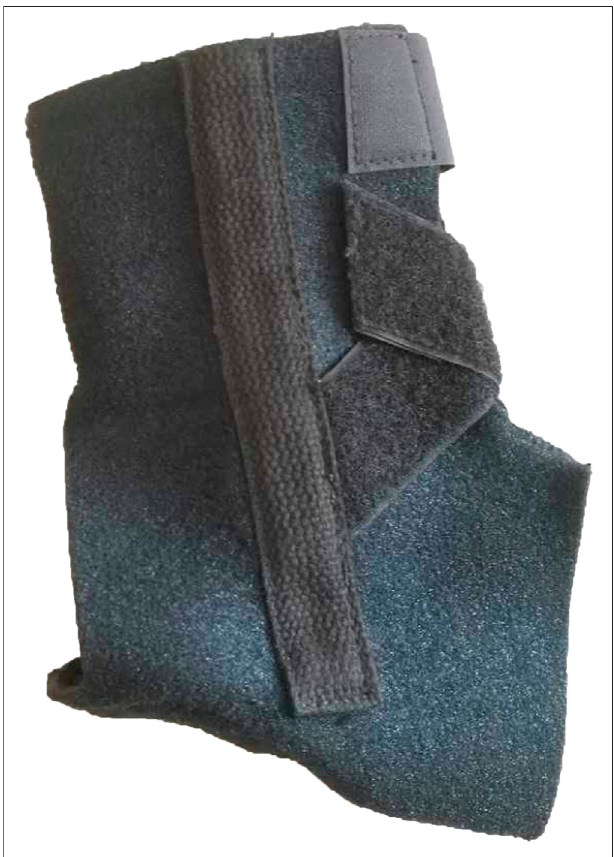
FIGURE 2 | The ankle brace in this